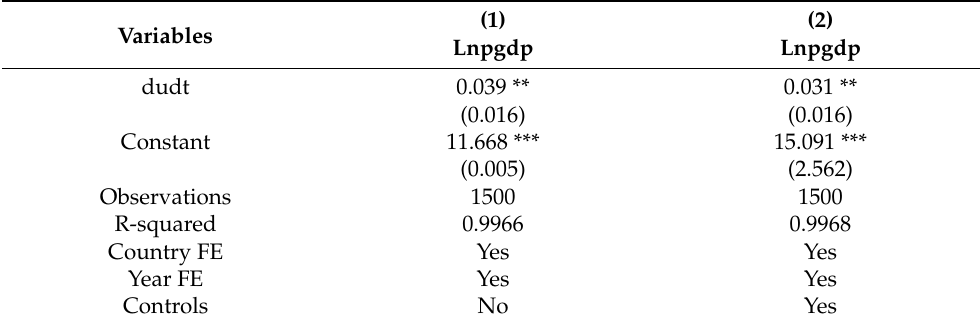
Table 2. The baseline regression